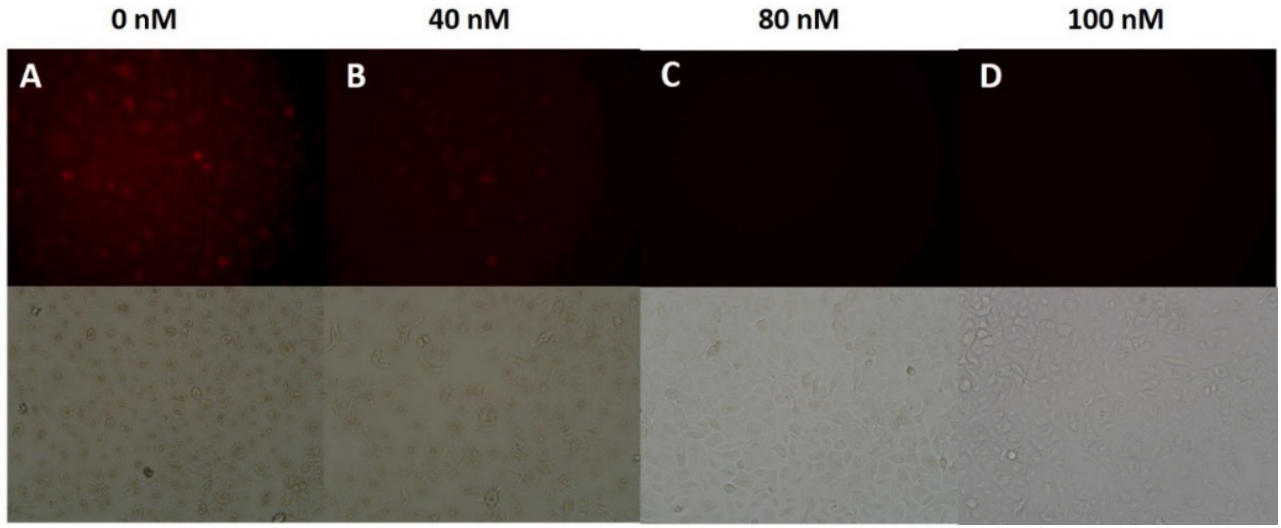
Figure 10. Fluorescence microscopy images of HeLa cells first incubated with 0–100 nM bafilomycin A1 for 9 h, then with a 5 μ M mPEG-b-P(PA-alt-AGERh) nanosensor for 6 h at 37 °C. The HeLa cells were incubated with 0 nM ( A ), 40 nM ( B ), 80 nM ( C ) and 100 nM ( D ), respectively. First row: fluorescence images at the red channel (560–700 nm) and second row: bright field images. λ ex = 560 nm.